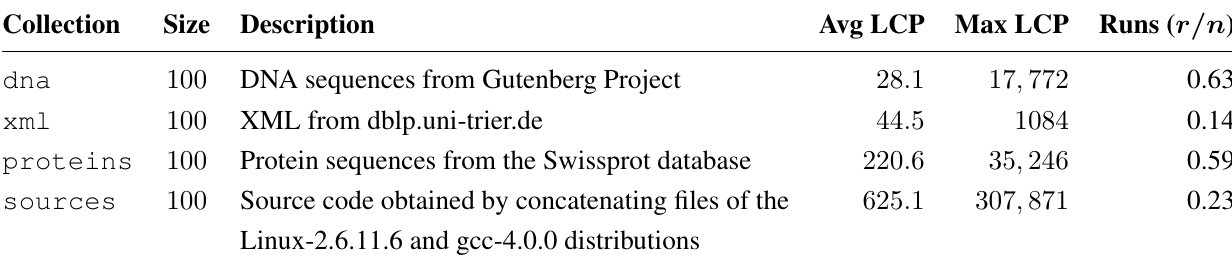
Table 2. Data files used for tests with their size in MB, plus some information on their compressibility.